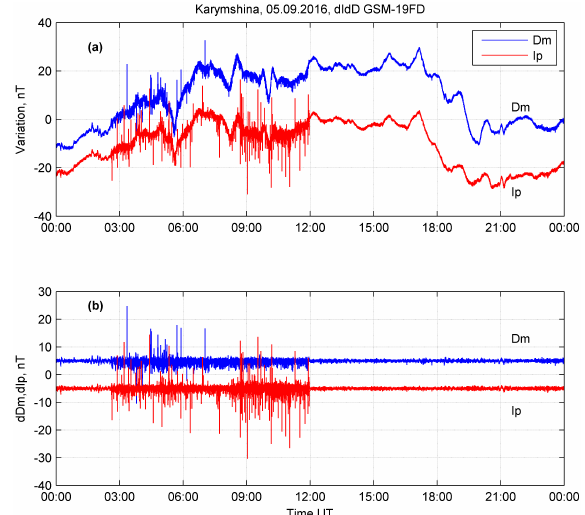
Figure 11. The noise in dIdD data which arose due to the failure of a power supply system at Karymshina station (15km from the Paratunka observatory). (a) The total field intensity F obtained in the case of additional fields with polarity west–east (Dm) and up– down (Ip) in the coil system (see dIdD Instruction Manual, 2010); (b) the same as in (a) , but slow variations are excluded (for